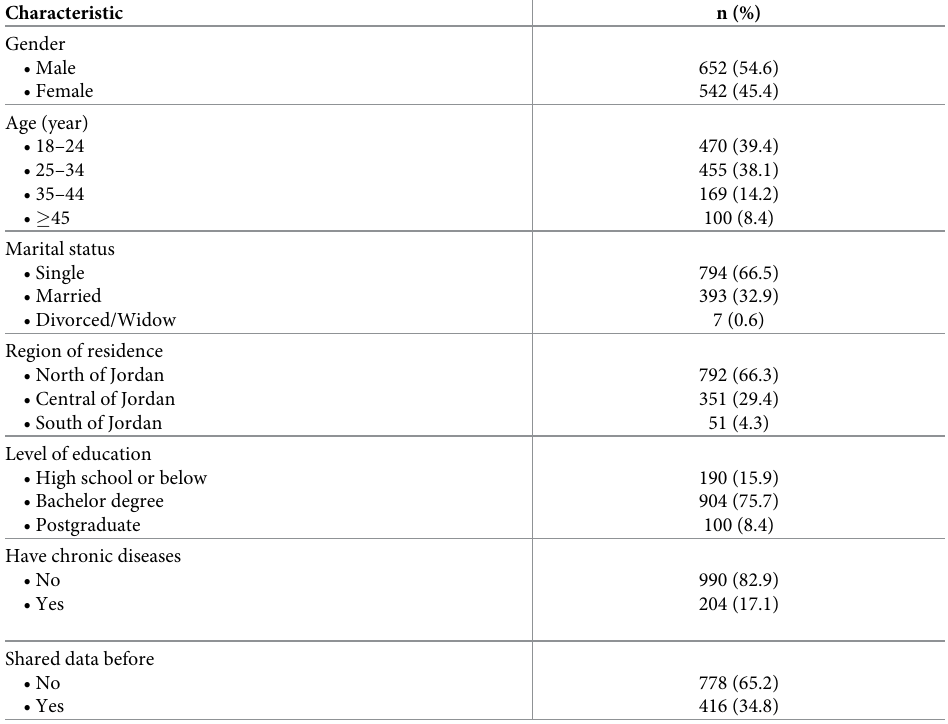
Table 1. Socio-demographic characteristics of the study population (n =